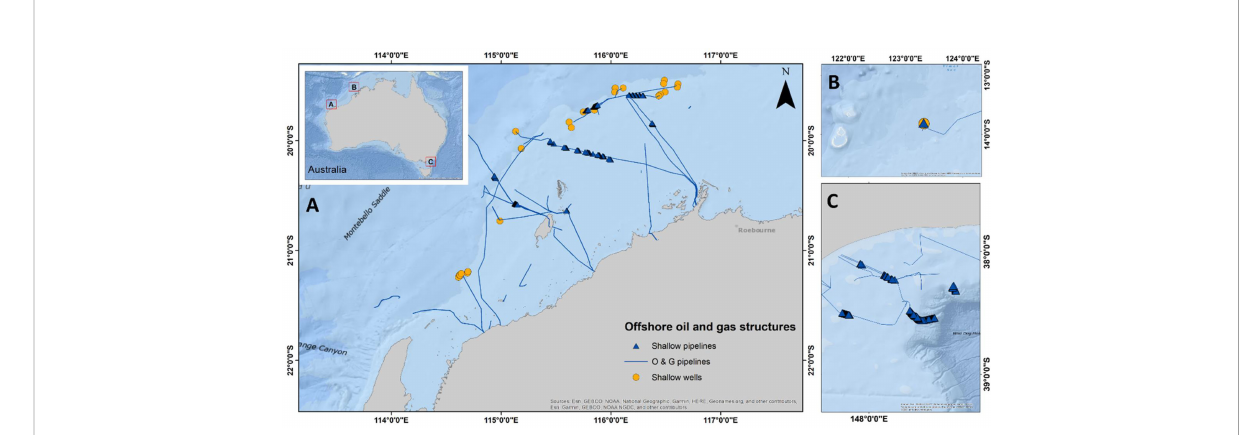
FIGURE 1 Location of wells (<150 m NW and<160 m SE) and pipelines (<400 m) surveyed for abundance of species targeted by fi sheries in (A) NW, (B) NW (Browse), and (C) SE marine regions of Australia. NW = north-west, SE =